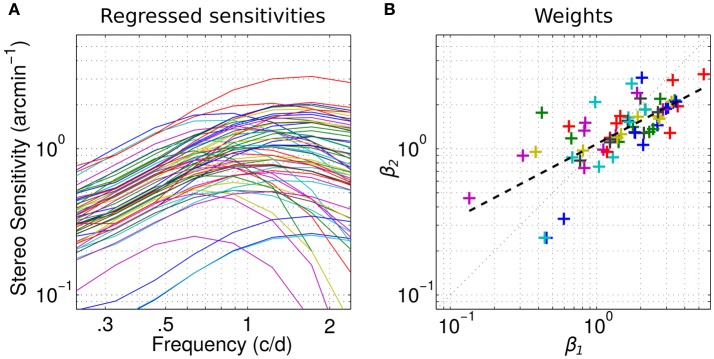
Channels weights. (A) Individual sensitivities replotted using only the two channels factors. Same color-code as in Figure 1. (B) Scatterplot of the weights of the first factor β1 vs. the weights of the second factor β2 for all observers. Dashed line indicates linear regression on the log-values of the weights.